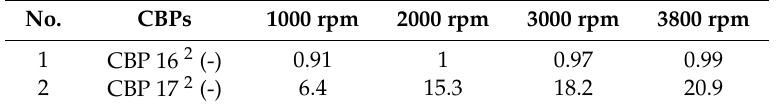
Table 6. Evaluated CBPs (Table 1) of the sub-system SS 5 at full-load operating